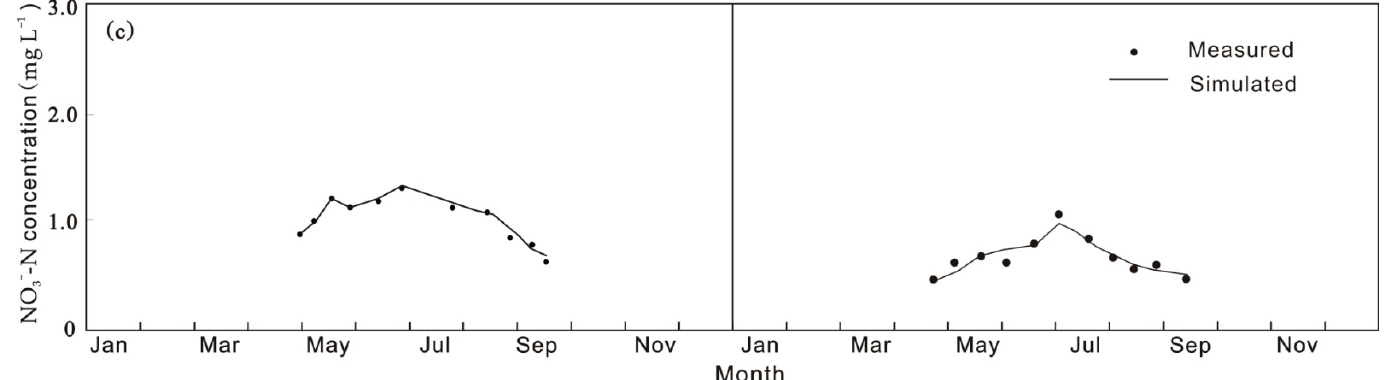
Figure 6. Comparison of ( a ) the simulated and measured flow rates, ( b ) NH 4+ -N concentrations, and ( c ) NO 3 − -N concentrations at the outlet of the drainage channel of the irrigation district. Table 3. Parameter and physical variable list.